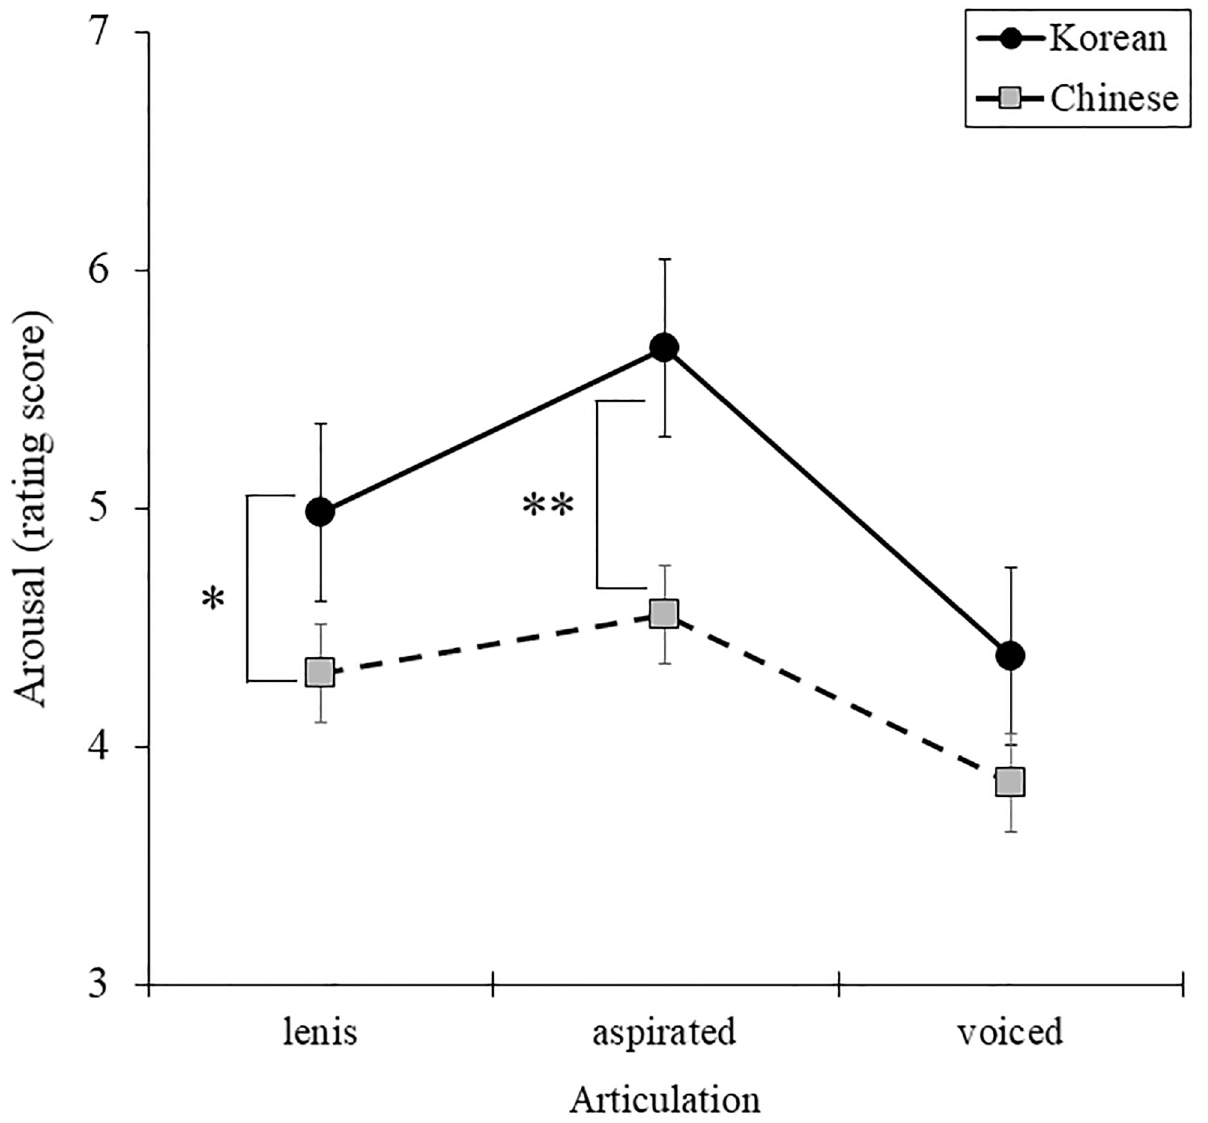
Fig 2. Comparison of arousal for nationality groups in